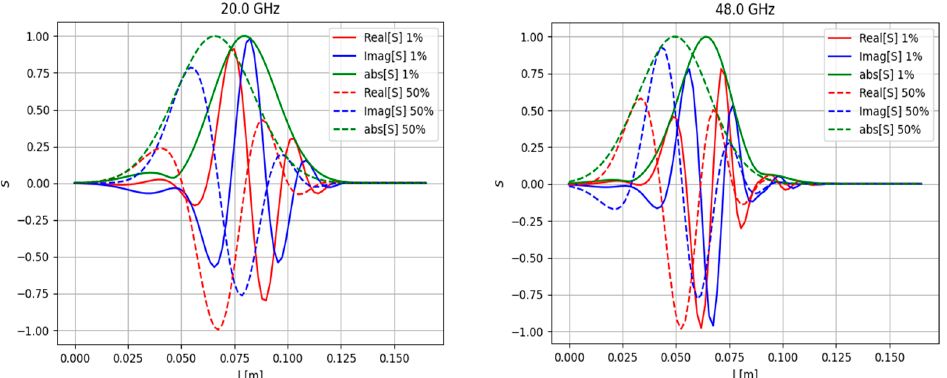
Figure 36. DBS signals calculated for the real Globus-M geometry ( left ) for the 20 GHz probing frequency and ( right ) for 48 GHz frequency. The regular lines correspond to filaments with amplitudes of 1% of density at cutoff of the probing wave, and the dashed lines correspond to filaments with amplitudes of 50% of density at cutoff of the probing wave.